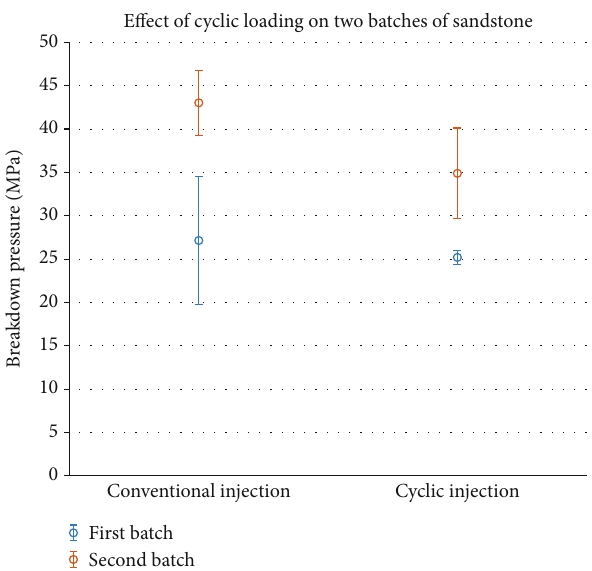
Figure 7: Average breakdown pressures for the fi rst and second batches of sandstone. The error bars represent the standard deviation of each category.